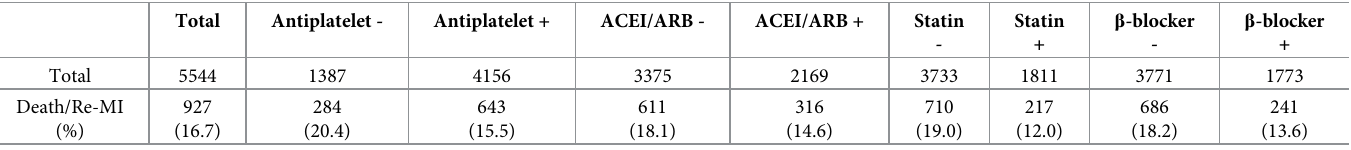
Statin β -blocker β -blocker - + - +